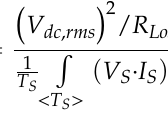
Figure 14. Efficiency comparisons according to PWM methods and switching frequencies. 6. Conclusion In this paper, a novel ± 180° DPWM is proposed to reduce switching losses of single ‐ phase PWM converters used in HSR propulsion systems. The conventional PWM converter for railway application has large switching losses due to the use of a high voltage ‐ rated IGBT device despite using relatively low switching frequency. To solve this problem, we modified the DPWM used in the three ‐ phase inverter to devise a ± 180° DPWM suitable for a single ‐ phase converter. By using the proposed modulation method, the switching state change can be reduced by half per every power cycle, and the switching losses can be reduced by half compared to the conventional CB ‐ SPWM when operated at the same switching frequency. In addition, it has been shown that the offset voltage can be selectively applied every half power cycle to solve the temperature unbalance problem between the power stacks. Simulation and experiments confirmed normal operation of the proposed DPWM and it has been found that the total power conversion losses including switching losses can be greatly reduced by utilizing the proposed DPWM. The DPWM proposed in this paper is expected to be widely used in high power systems using high ‐ voltage IGBTs as switching devices. Author Contributions: Conceptualization, M. ‐ S.S.; methodology, M. ‐ S.S., I. ‐ H.C., and J. ‐ B.L.; software, J. ‐ B.L.; validation, M. ‐ S.S., I. ‐ H.C., and J. ‐ B.L.; formal analysis, M. ‐ S.S.; experiments, M. ‐ S.S., I. ‐ H.C, and J. ‐ B.L.; writing—original draft preparation, M. ‐ S.S; writing—review and editing, M. ‐ S.S. and I. ‐ H.C.